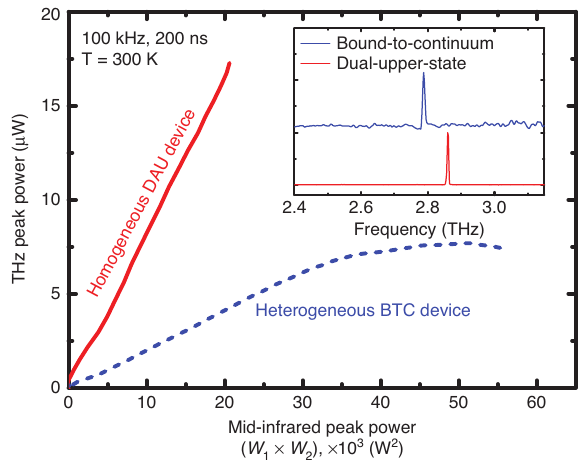
Figure 4: Terahertz peak power output versus the product of mid-IR pump powers for a device with the DAU active region (solid lines) and a device with the heterogeneous BTC active region at 300 K (dashed line).